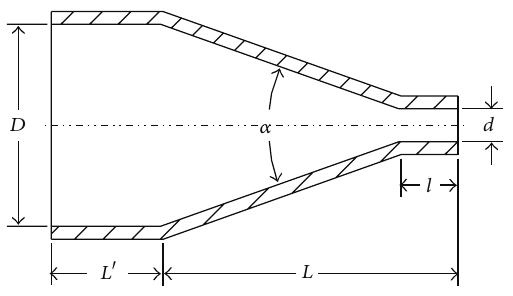
Figure 4: Main nozzle structural